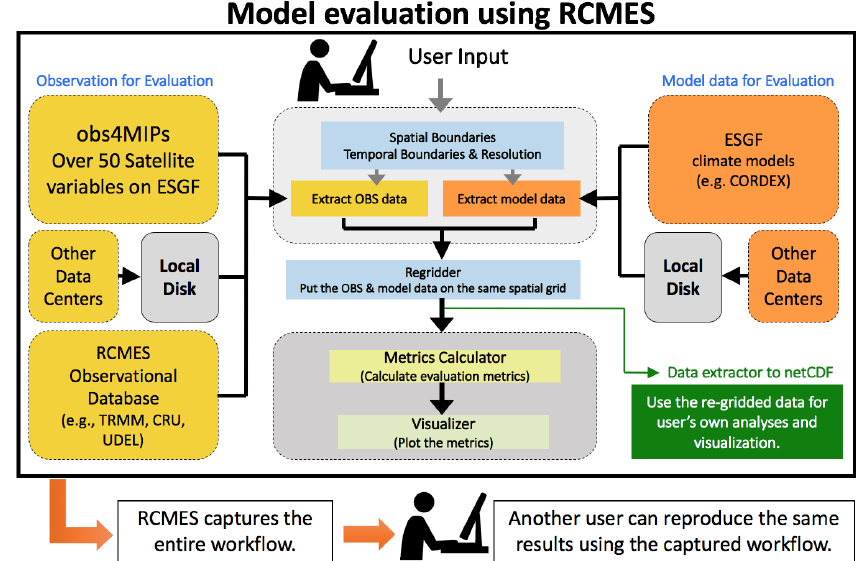
Figure 1. The outline and data flows within RCMES (adapted from JPL, 2018a).